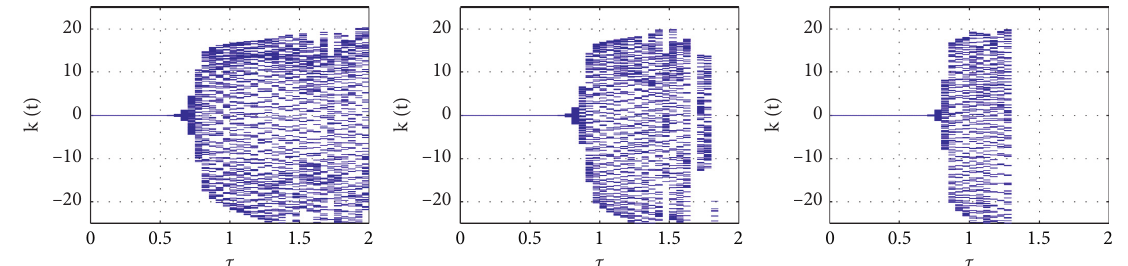
Figure 7: Bifurcation diagrams at a � 0.125 and q � 0.5, 0.75, and 1,